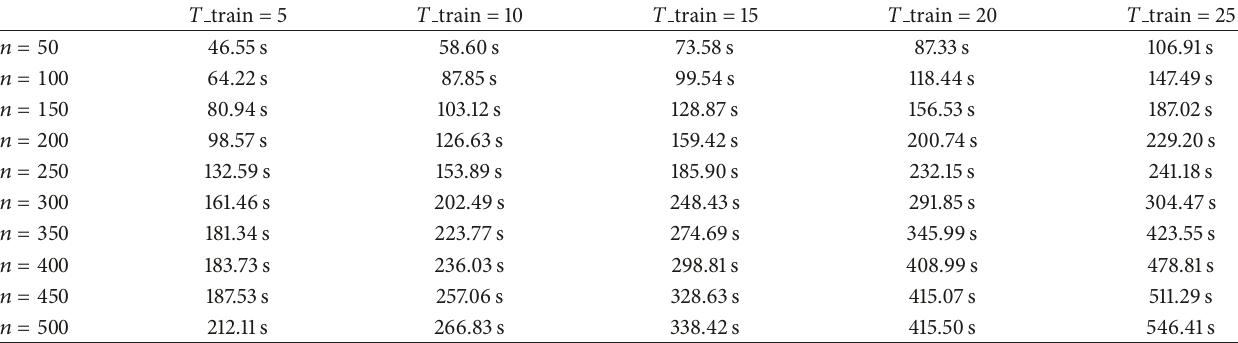
Table 4: Average computation time of our proposed method CDFAG. T train denotes the number of training samples in the target dataset. 𝑛 denotes the feature dimension in the common latent space.